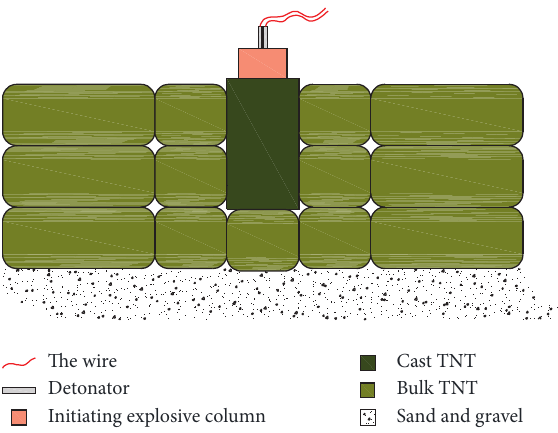
Figure 3: Cross section of explosive arrangement on the